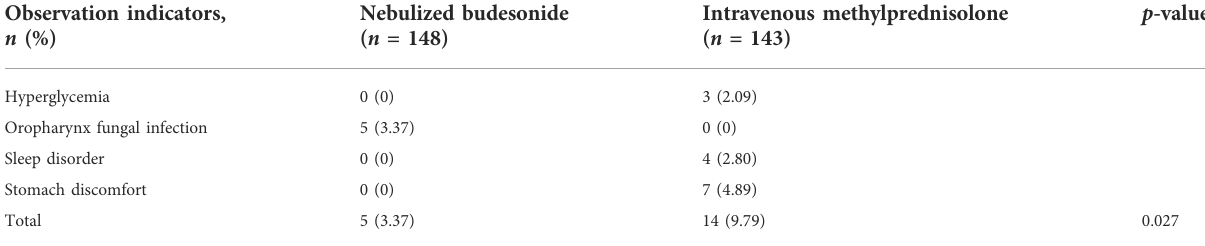
TABLE 3 Adverse events between the two groups. Observation indicators, n